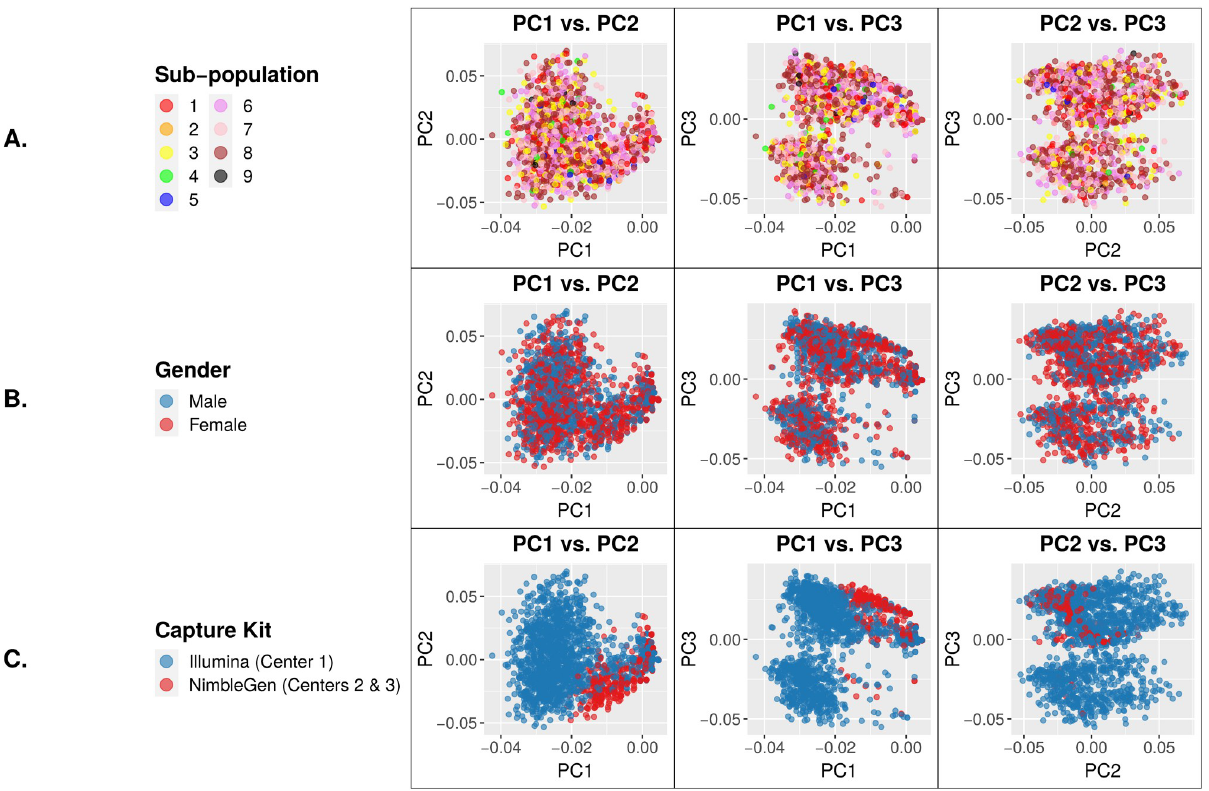
Fig 3. PC eigenvector plots of genotypes at 29 exome-wide significant SNPs. Each data point represents a single individual. Clustering of samples for a particular variable indicates genotypic similarity between individuals for the trait represented by that color. (A) PCs color coded based on sub- population. (B) PCs color coded based on gender. (C) PCs color coded based on capture kit. The NimbleGen-captured samples cluster tightly together, indicating their genotypic similarity that is distinct from the Illumina-captured samples.